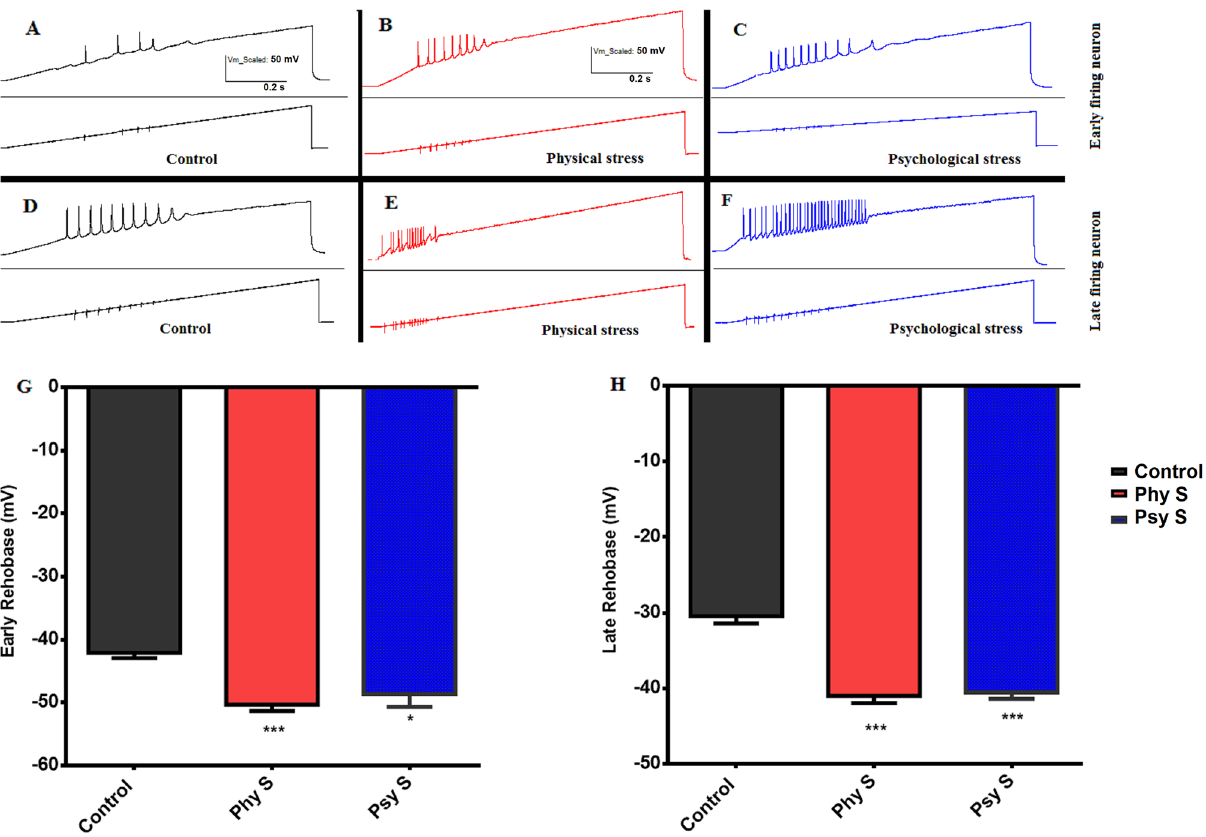
Figure 8. Response of early-firing neurons ( A – C ) and late-firing neurons ( D , F ) to Ramp flow injection pulses (0 pA to 2nA lasting 1000 ms) and their corresponding early ( G ) and late ( H ) rheobase. Data are represented as Mean ± SEM. *** ( p < 0.001) * ( p < 0.05) shows a significant difference compared to the control group. Phy S: Physical stress, Psy S: Psychological